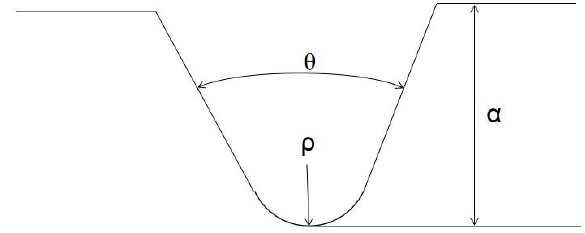
Figure 4. The notch draft of the specimen.